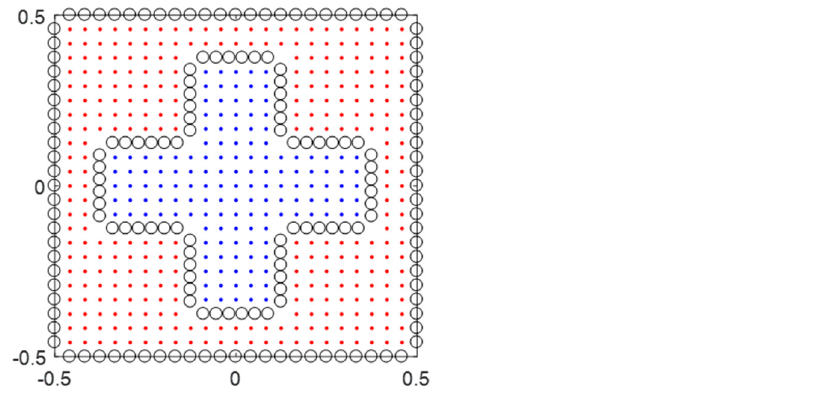
Figure 12. Nodes distribution for the unit cell of phononic crystal with cross-shaped scatterer.